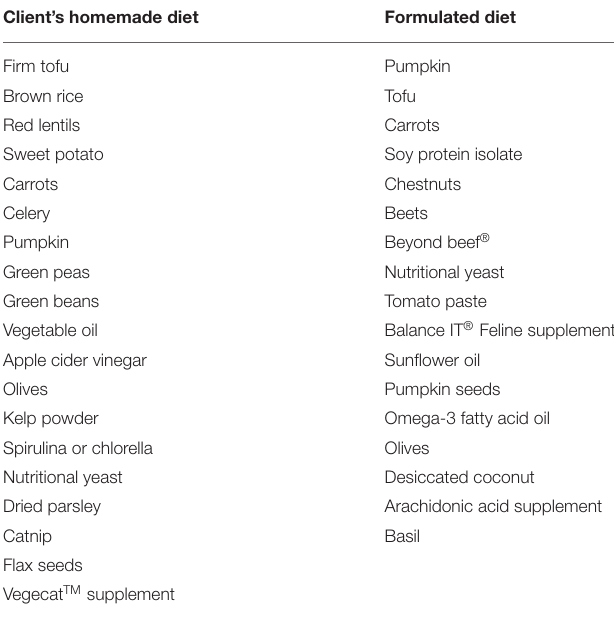
TABLE 4 | Homemade feline diet recipe, ingredients listed from highest to lowest inclusion (by